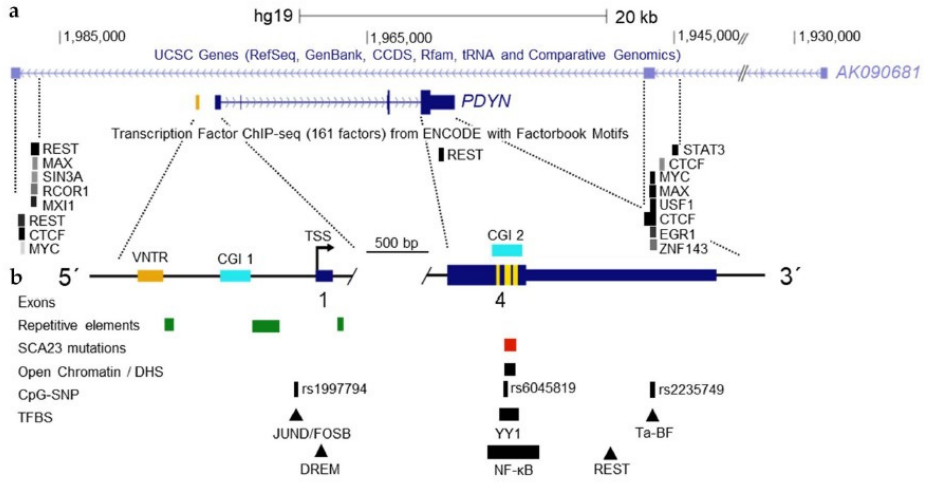
Figure 4. Locus of human PDYN with targets for transcription factors. ( a ) Genomic organization showing PDYN , the antisense AK090681 transcript and transcription factor targets deposited on UCSC Genome Browser. ( b ) Verified and putative transcription factor binding elements, promoter VNTR, CpG islands 1 and 2 (CGI 1 and CGI 2), PDYN pathogenic mutations causing neurodegeneration, and DNase I hypersensitivity sequence (DHS), and CpG-SNPs association with alcoholism. Thin light blue line shows non-coding RNA, thick dark blue line coding region, vertical yellow lines dynorphin sequences. Modified from